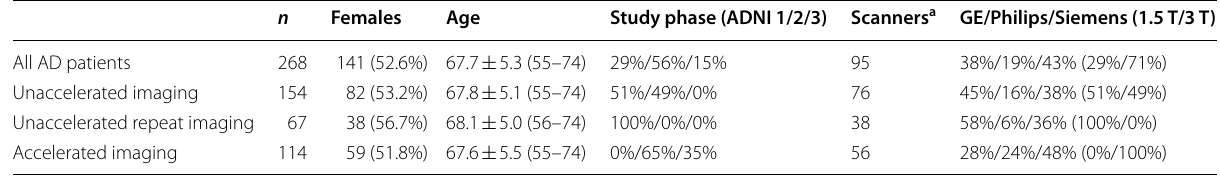
Table 1 Demographics of all included patients from the Alzheimer’s Disease Neuroimaging Initiative (ADNI) as well as the analyzed